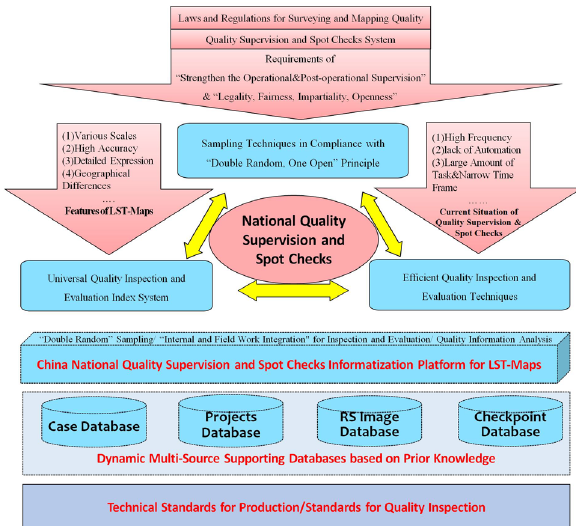
Figure 1. Problems and Overall Concept of